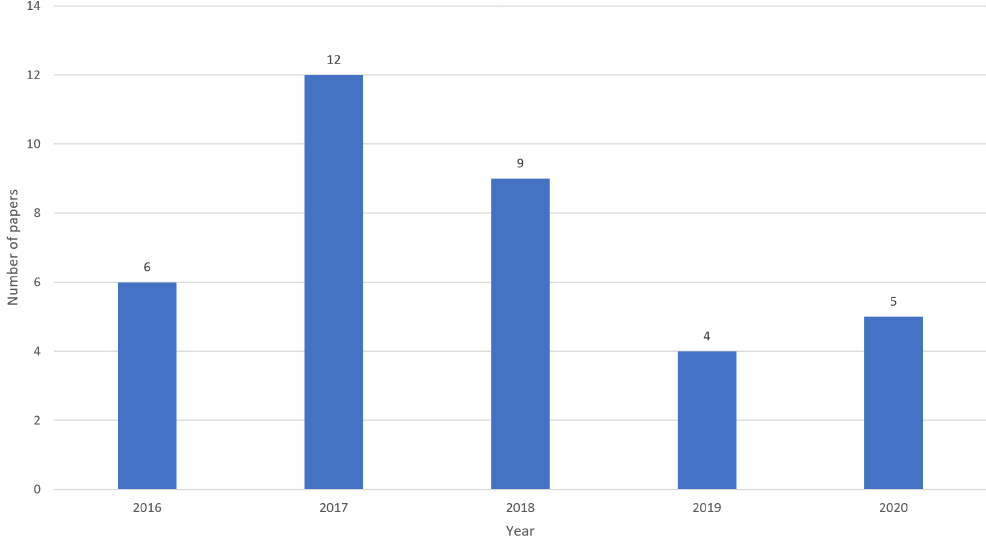
Figure 1. Number of papers per